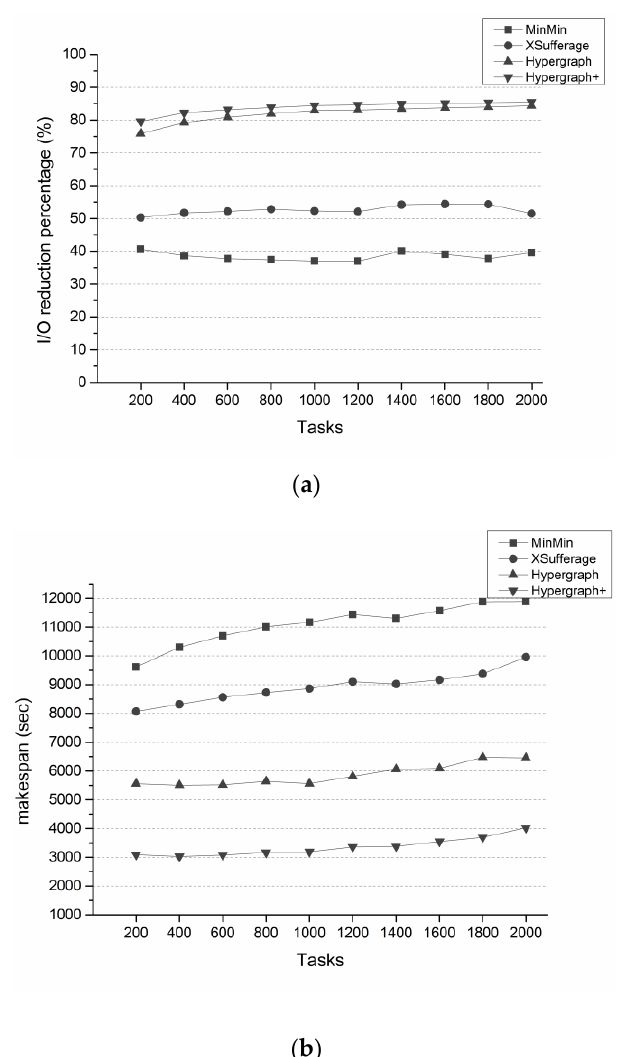
Figure 10. Performance evaluation with different numbers of tasks. ( a ) Makespan; ( b ) I/O reduction percentage.